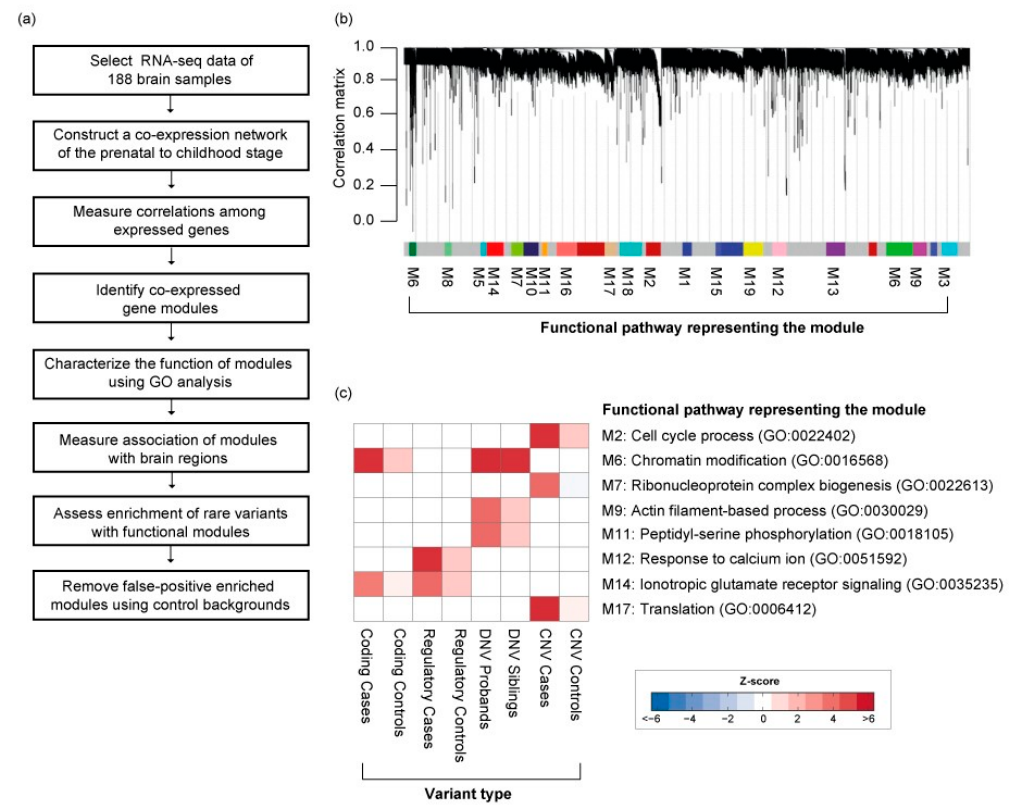
Figure 3. Co-expressed gene network in the early neurodevelopment stage. ( a ) Detailed workflow for the construction of the co-expression gene network. ( b ) Co-expression gene modules enrichment with rare variations. ( c ) Type of rare variation found enriched in co-expressed gene